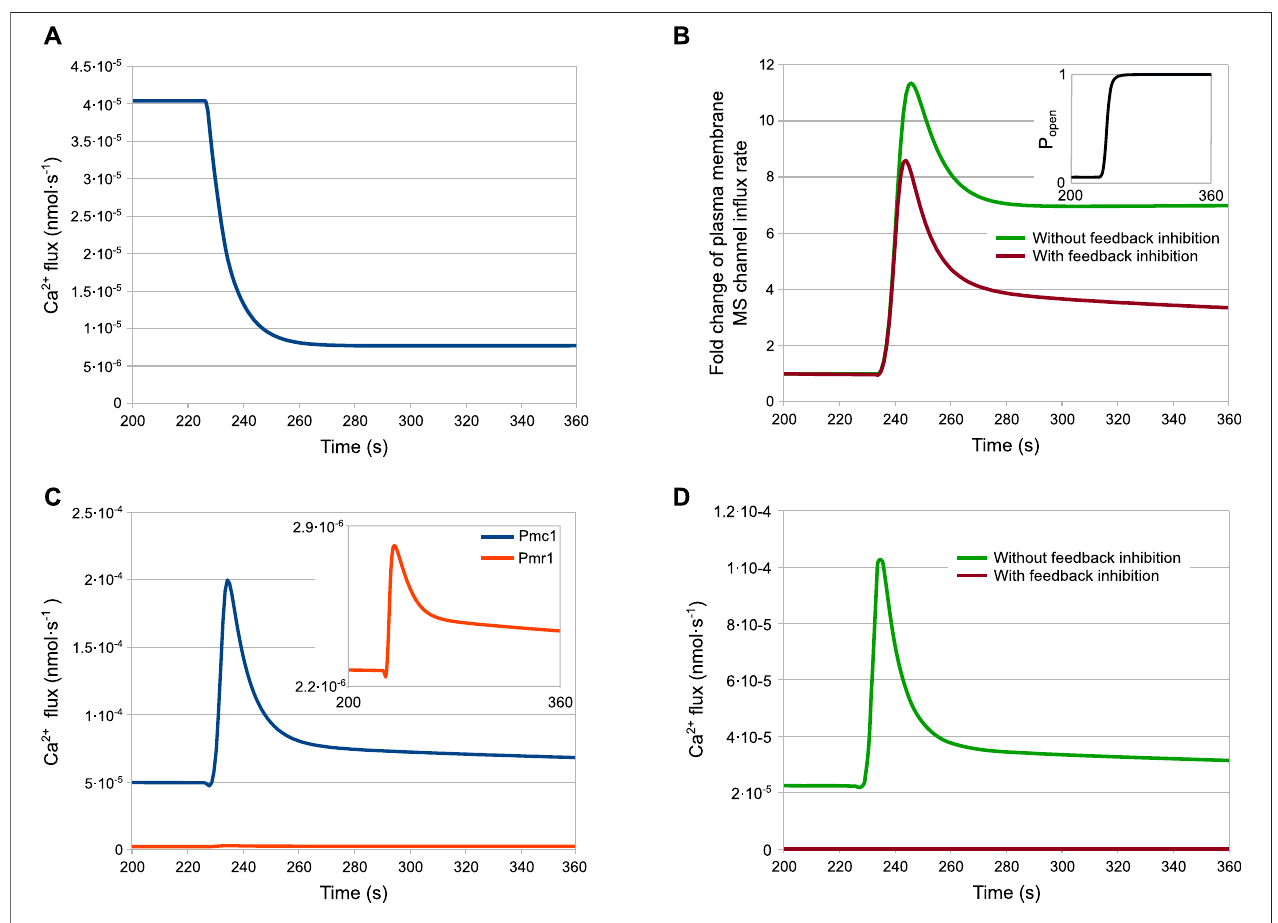
FIGURE 4 | Fluxes involved in the HTS response of the wild-type strain. (A) HACS fl ux. (B) Effect of calmodulin inhibition on MS channels. (C) Pmc1 and Pmr1 fl uxes. (D) EffectofcalcineurininhibitiononVcx1 (A – D) Ca 2+ fl uxesthroughchannelsandtransportersaspredictedbythemodel(parametersaregivenin Table2 ) (B,D) Fluxes with or without inhibition are depicted by plotting j MS and j 0 MS for MS channel, and j Vcx1 and j 0 Vcx1 for the Vcx1 transporter. Inset in (B) shows how the opening probability ofMS channels changes withtime (note thatitisnot equaltozero beforethe stimulus).Fluxes in (B) arenormalised totheir steady-state valuestobetter appreciate the long-term effect of channel